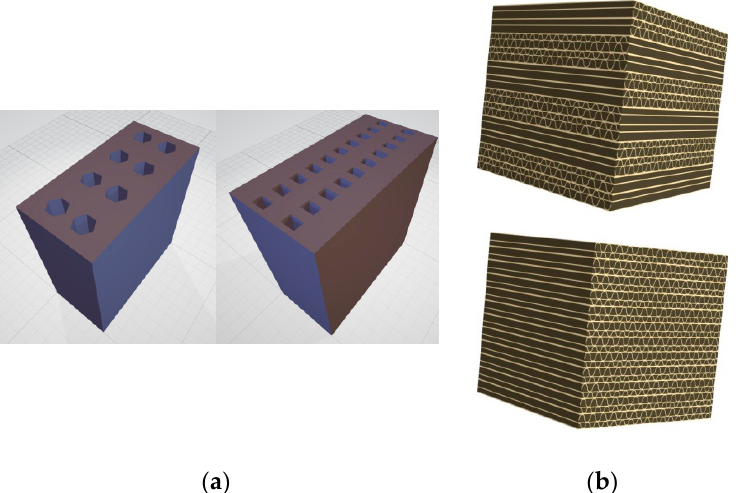
Figure 1. The preliminary project. From left, panel type ( a ), hexagonal and square section; from right, panel type ( b ), 2 × 2 orthogonal layers and parallel layers.